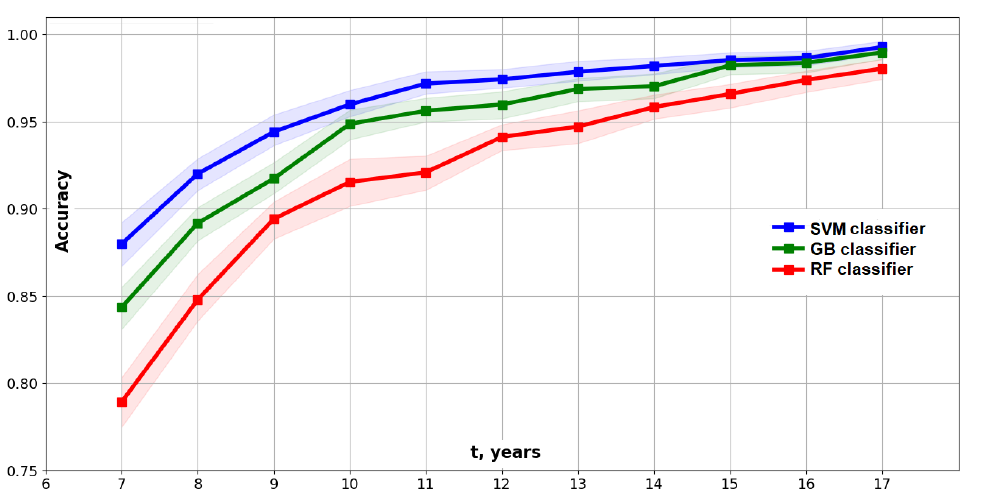
Figure 17. Accuracy of the Type III model: mean values and 95% confidence intervals. Using a linear interpolation of the bootstrapped accuracy data, we estimated the time ˆ T , when it is possible to predict a steady state with 95% accuracy for each model type and each classifier (see Table